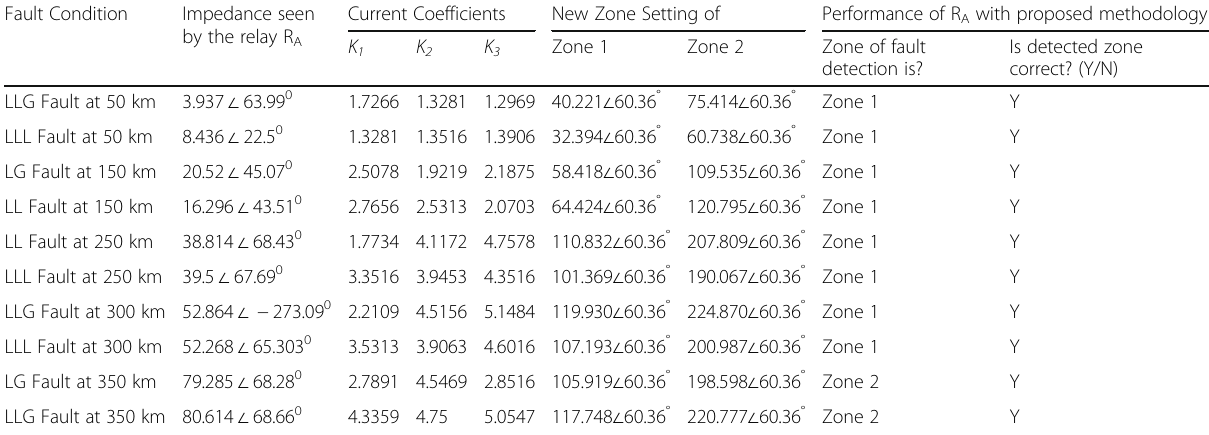
Table 9 Performance of distance relay R A with PAZSD methodology for different faults with FR = 4.9 Ω at different distances Fault Condition Impedance seen by the relay R A